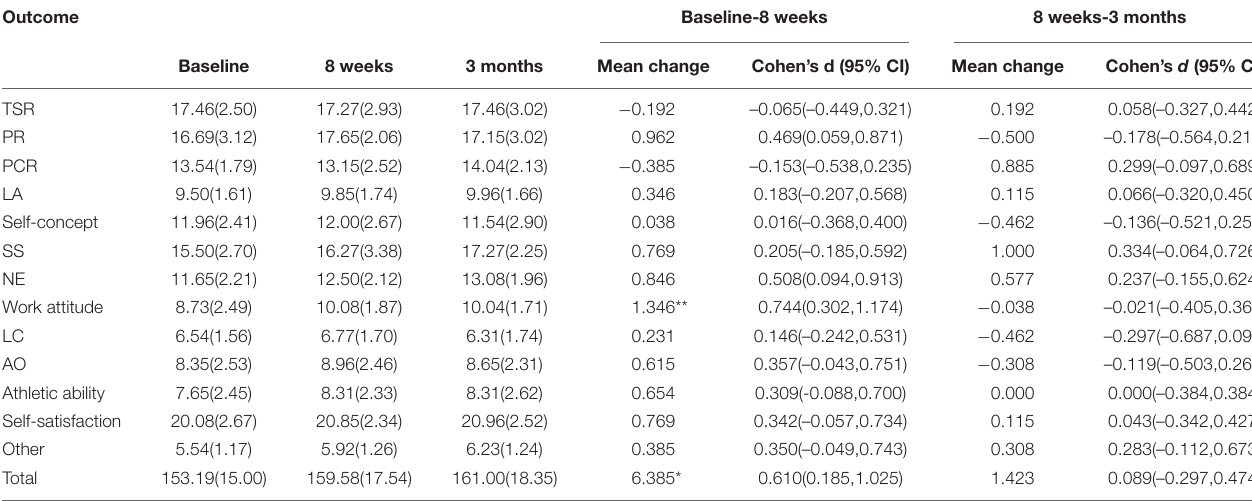
TABLE 3 | Baseline, 8 weeks and 3 months quality of life variable descriptive